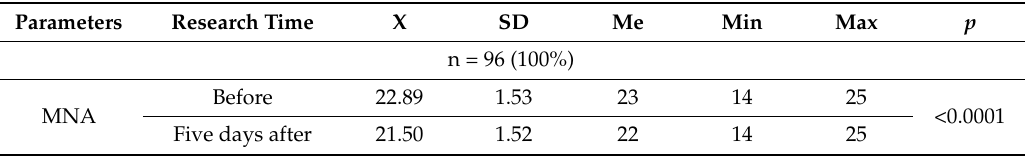
Table 5. Statistical analysis of the nutritional status of patients who underwent CABG based on MNA parameter. Parameters Research Time